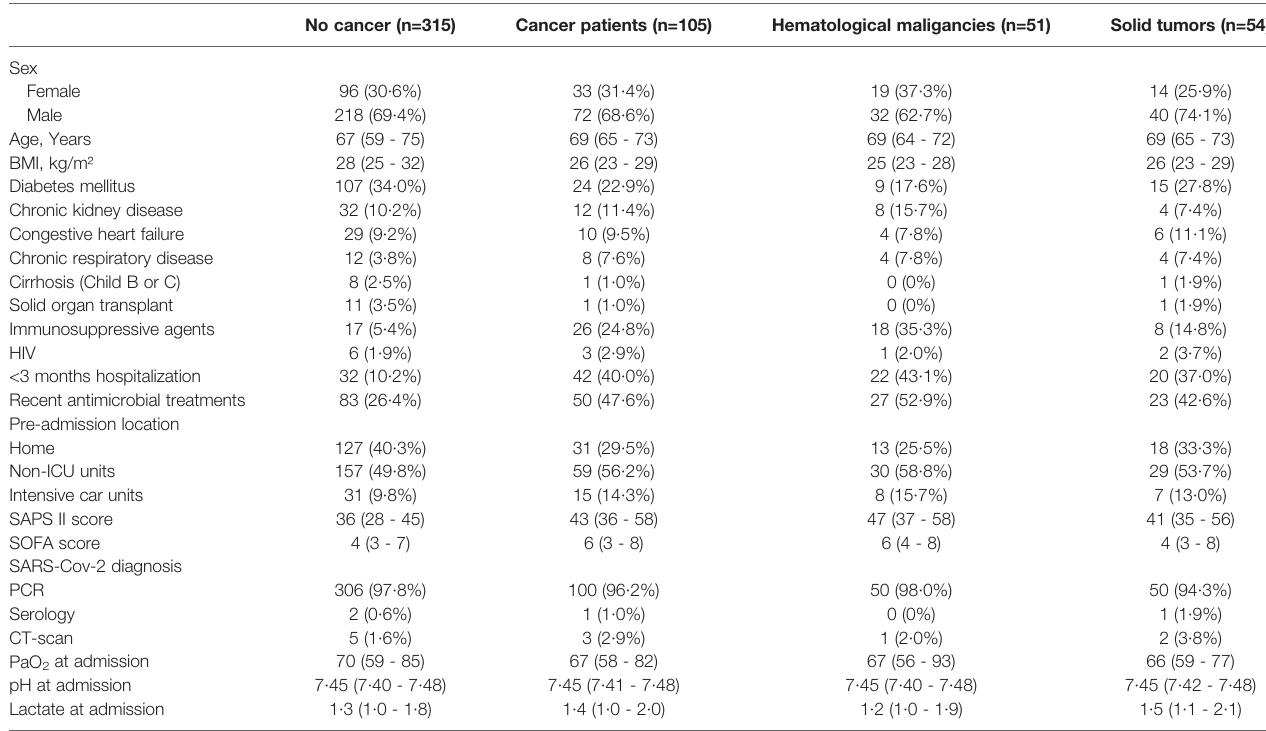
TABLE 1 | Patients characteristics at